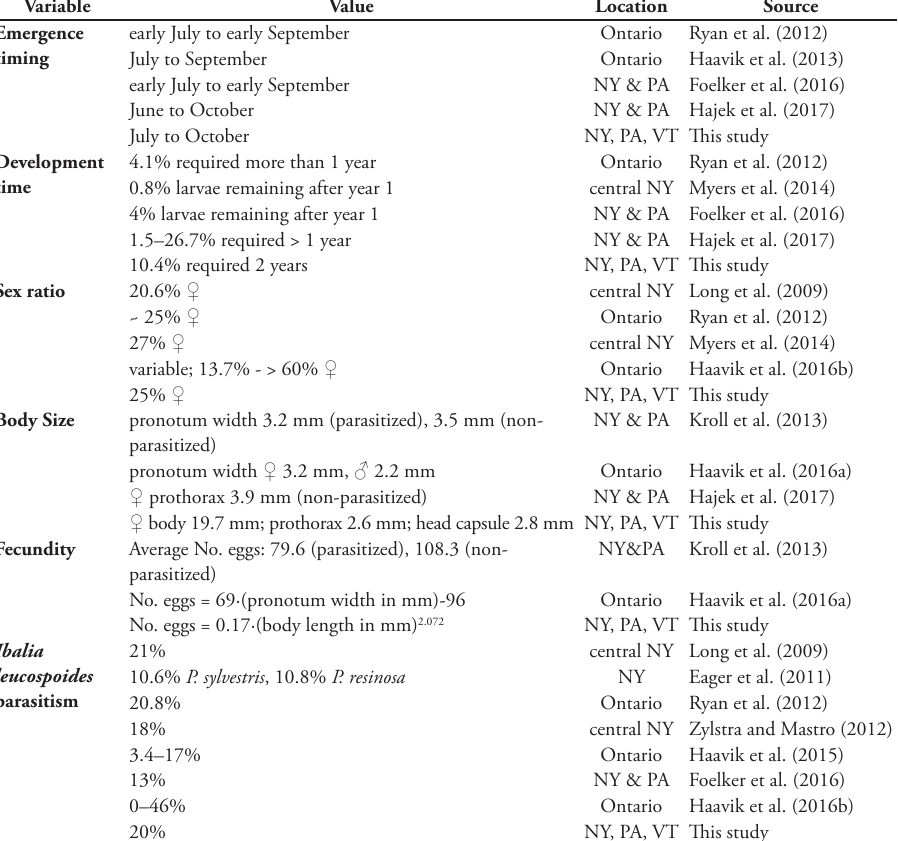
Table 1. Life history parameters reported in previous studies in North America. Summary of findings to date from all North American studies that have assessed aspects of Sirex noctilio life history. Variables include timing of emergence, voltinism, sex ratio, body size, fecundity, parasitism and larval